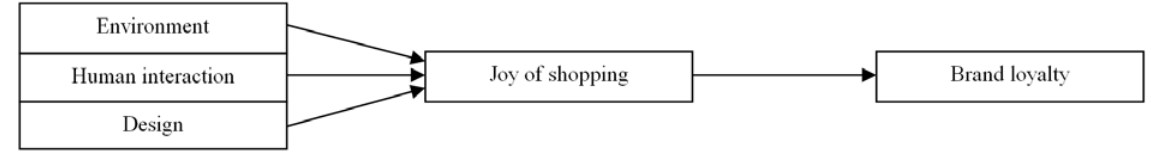
Fig. 1. Research conceptual model